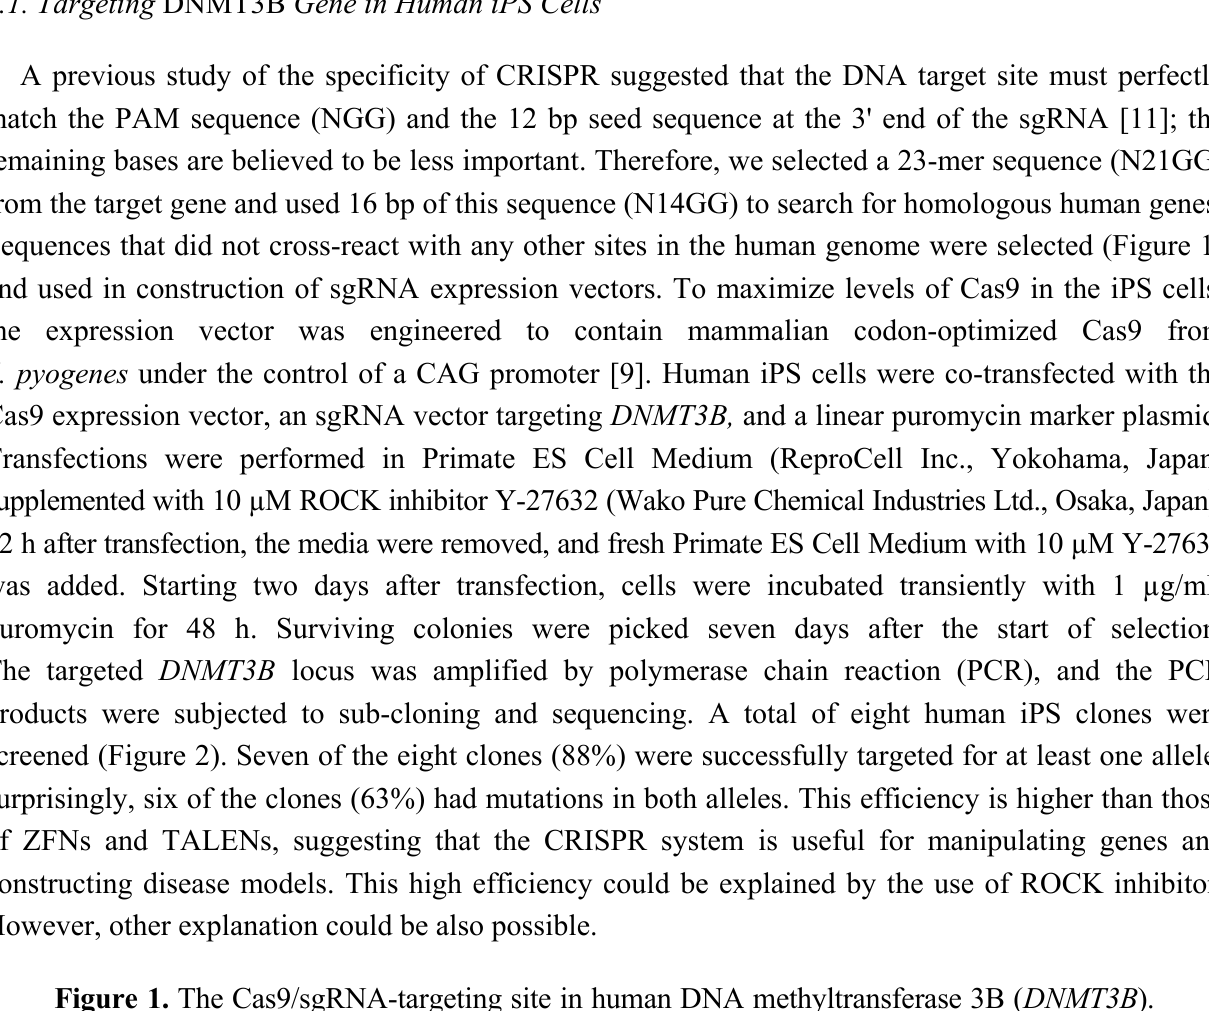
Figure 1. The Cas9/sgRNA-targeting site in human DNA methyltransferase 3B ( DNMT3B ). The sgRNA-targeting sequence is underlined, and the PAM (protospacer-adjacent motif) sequence is indicated in red. Exons are indicated by closed